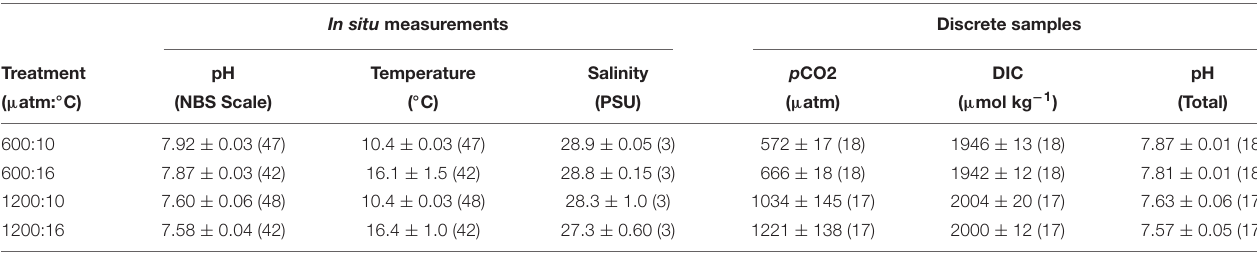
TABLE 1 | In situ seawater parameters and calculated discrete carbonate chemistry values during experiments. In situ measurements Discrete samples